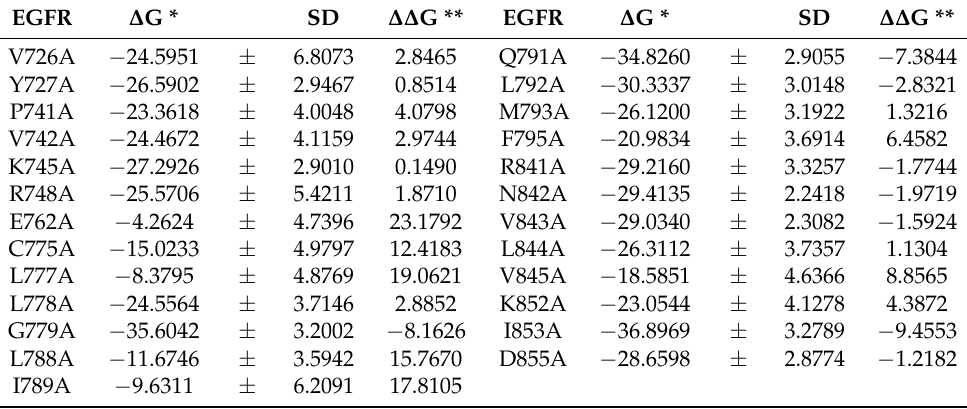
Table 2. Free binding energy of ATP to mutated EGFR.